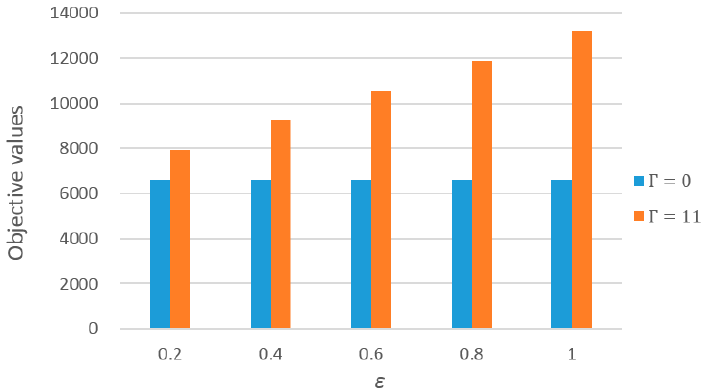
Figure 2. Comparison of objective values corresponding to the minimum and maximum values of the uncertainty degree ( n = 12).